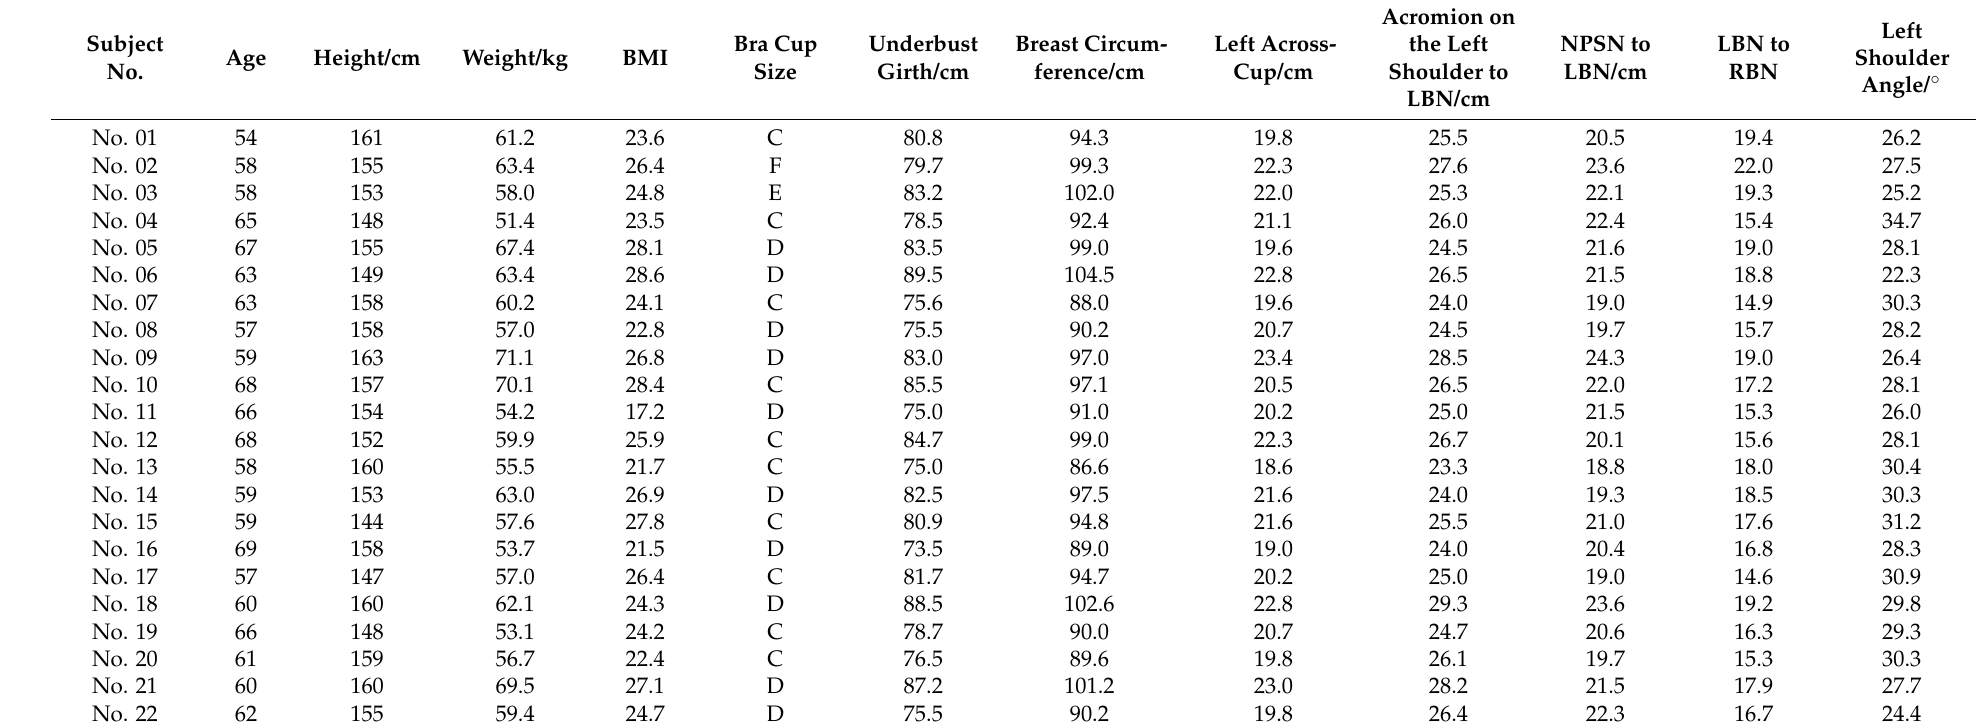
Table 1. The value of body parameters for each